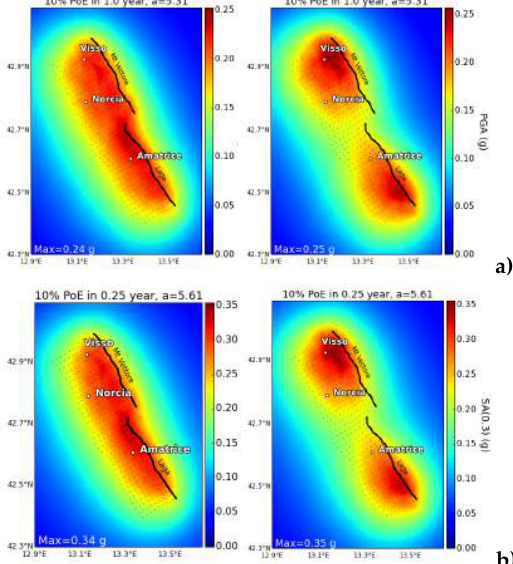
Figure 5: APSHA maps showing: a) PGA for rock sites (CY14) at 10% in 1 year from October 1, 2016, using uniform and non-uniform rates with topography; b) the same but SA (0.3s) in the next 3